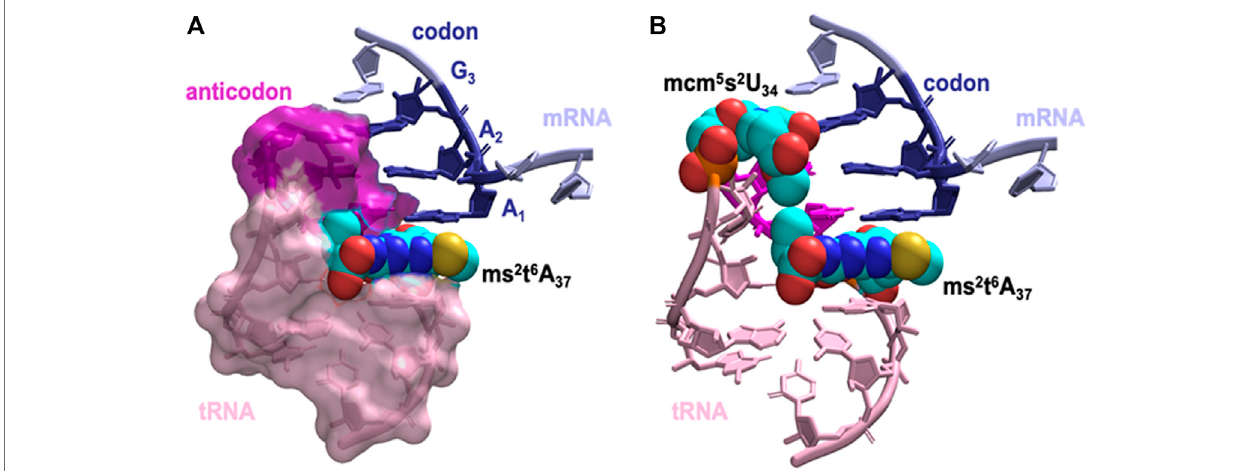
FIGURE 6 | The dominant orientation of the hypermodi fi ed ms 2 t 6 A 37 shown in space fi lling model interacting with the anticodon stem loop cavity. (A) The terminal carboxyl group of the threonylcarbamoyl-group faces away from the ASL cavity, while the aliphatic carbons and the terminal methyl group fi ll up the cavity. Stacking between A1, A 37 and A 38 is enhanced by the addition of the thiomethyl-group to t 6 A 37 , ms 2 t 6 A 37 . (B) The interaction between hypermodi fi ed ms 2 t 6 A 37 and mcm 5 s 2 U 34 shown in space fi lling model. Hydrophobic contacts between the two modi fi ed nucleotides assists mcm 5 s 2 U 34 in maintaining the anticodon:codon interaction at the wobble